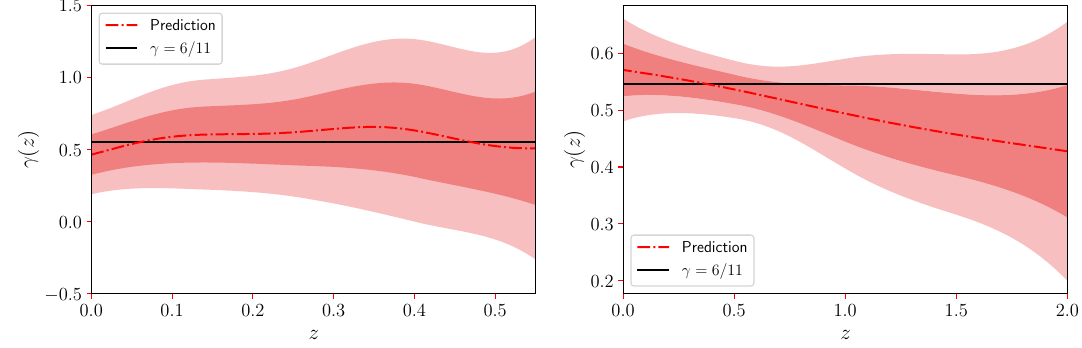
Within the context of the (cid:4) CDM model, CMB tem- perature fluctuations measurements from Planck and